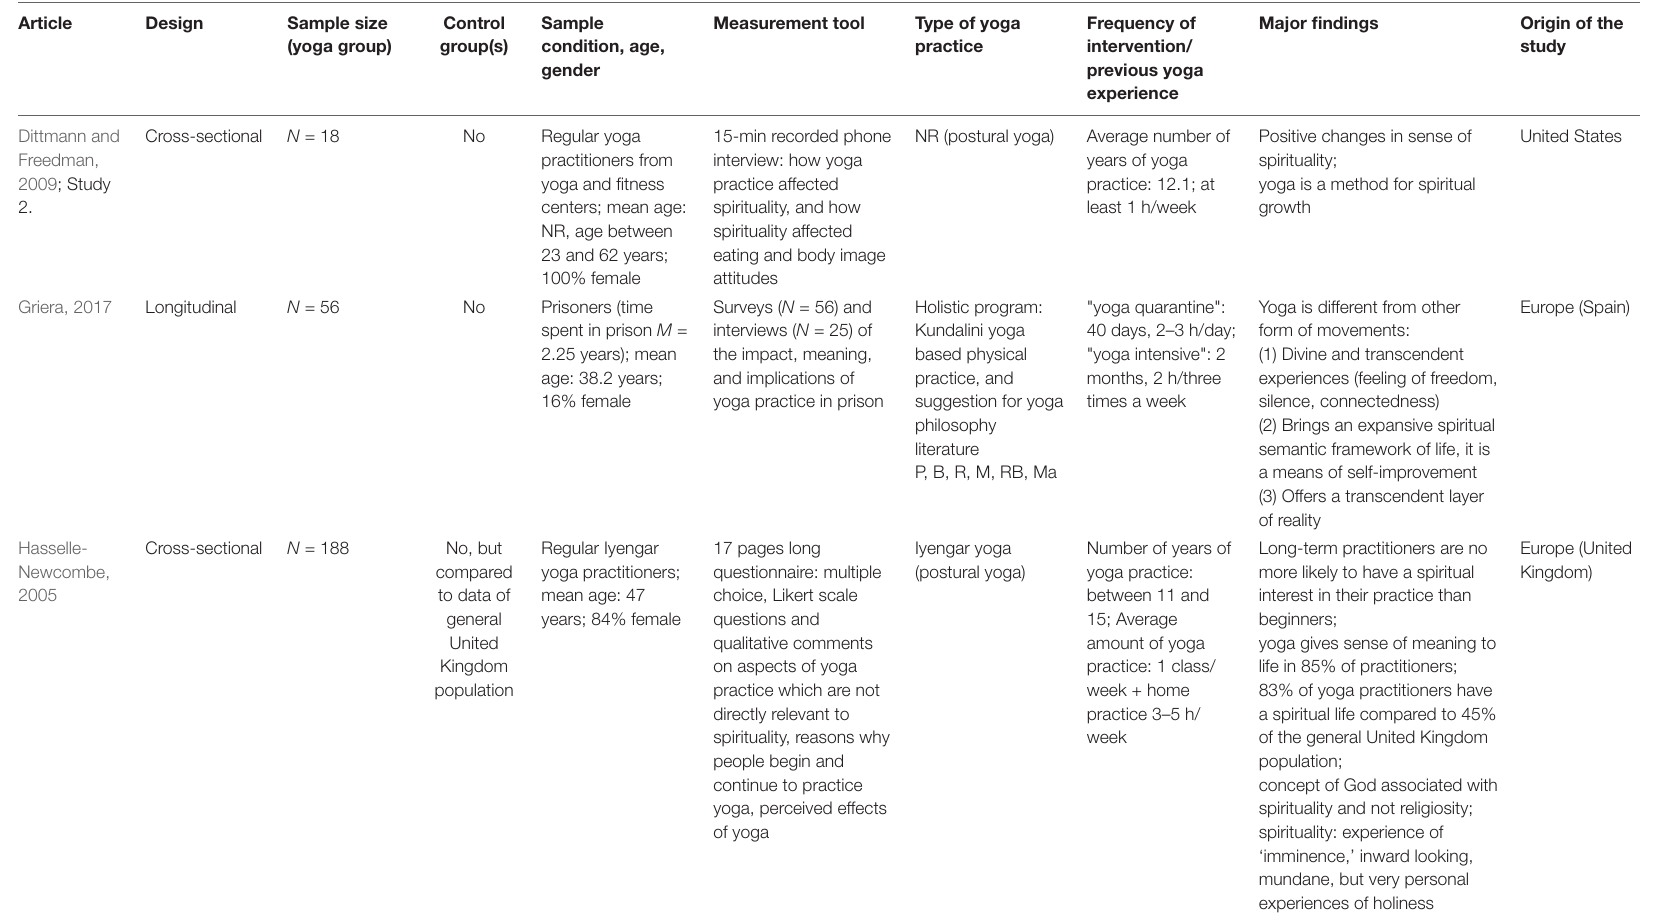
TABLE 1 | Summary of the articles with qualitative